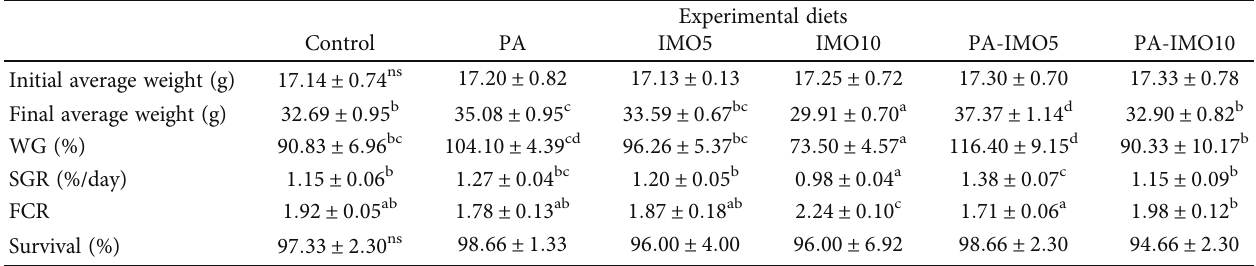
Table 1: Growth parameters of common carp fed di ff erent levels of Pediococcus acidilactici (PA) and isomaltooligosaccharide (IMO) after 8 weeks.